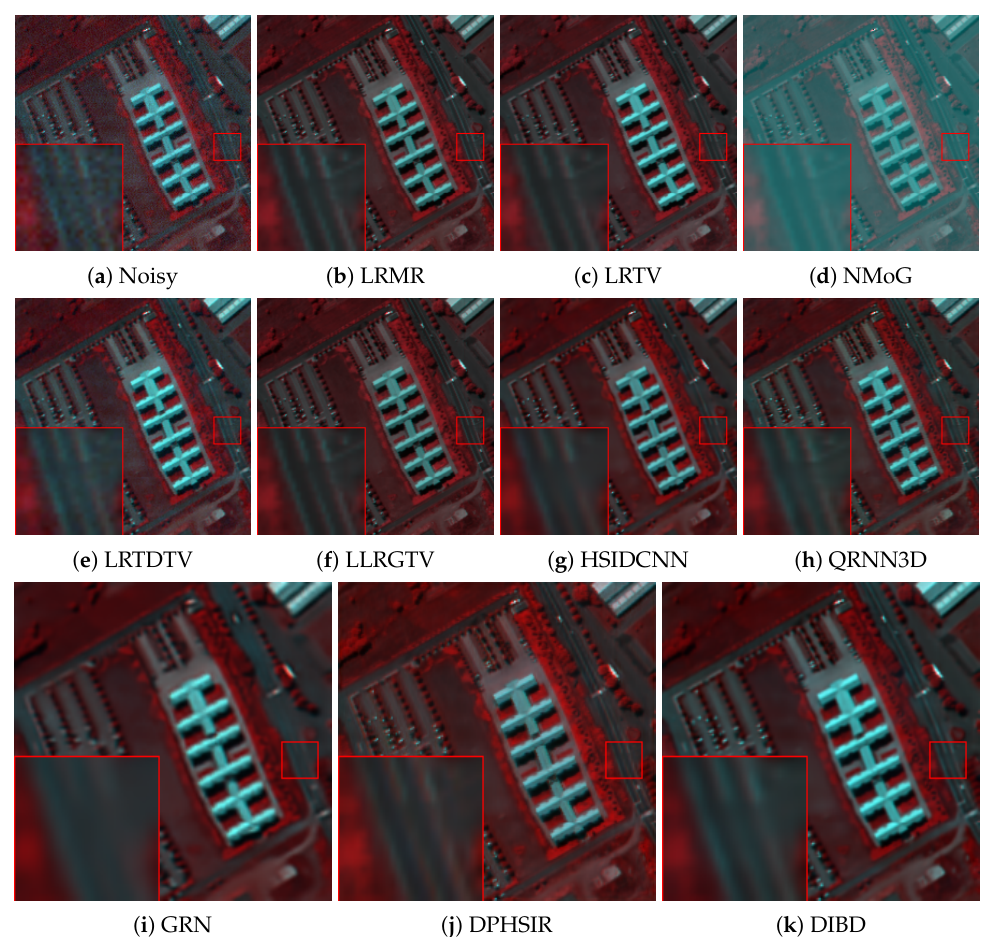
Figure 8. Pavia university denoising results. The RGB image is synthesized by HSI bands 78, 3, 2.